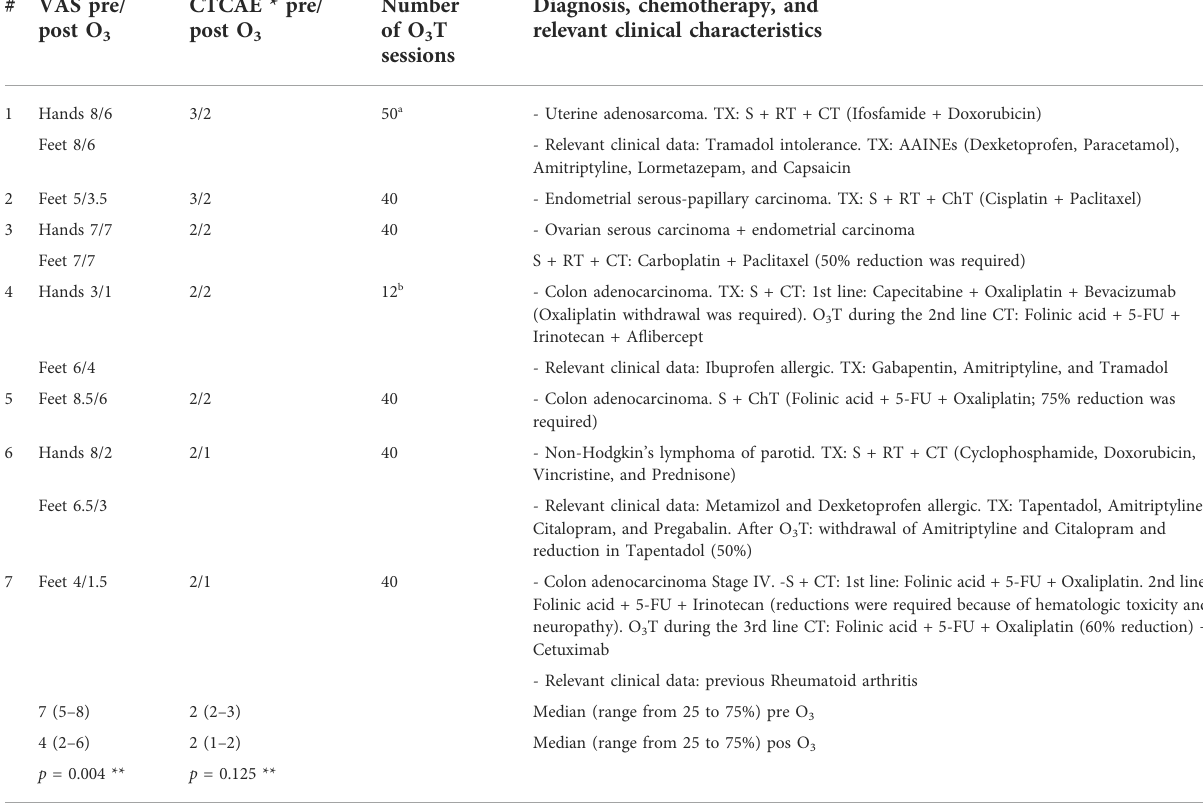
TABLE 1 Clinical characteristics and patient-reported changes in numbness, tingling, pain, and toxicity